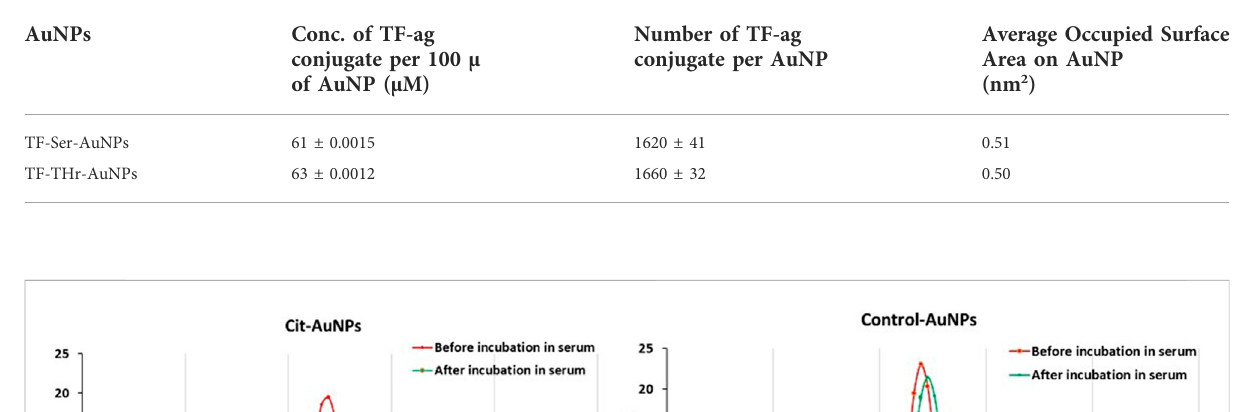
TABLE 2 Copy number and surface occupancy of ligands on the TF ag -containing AuNPs.